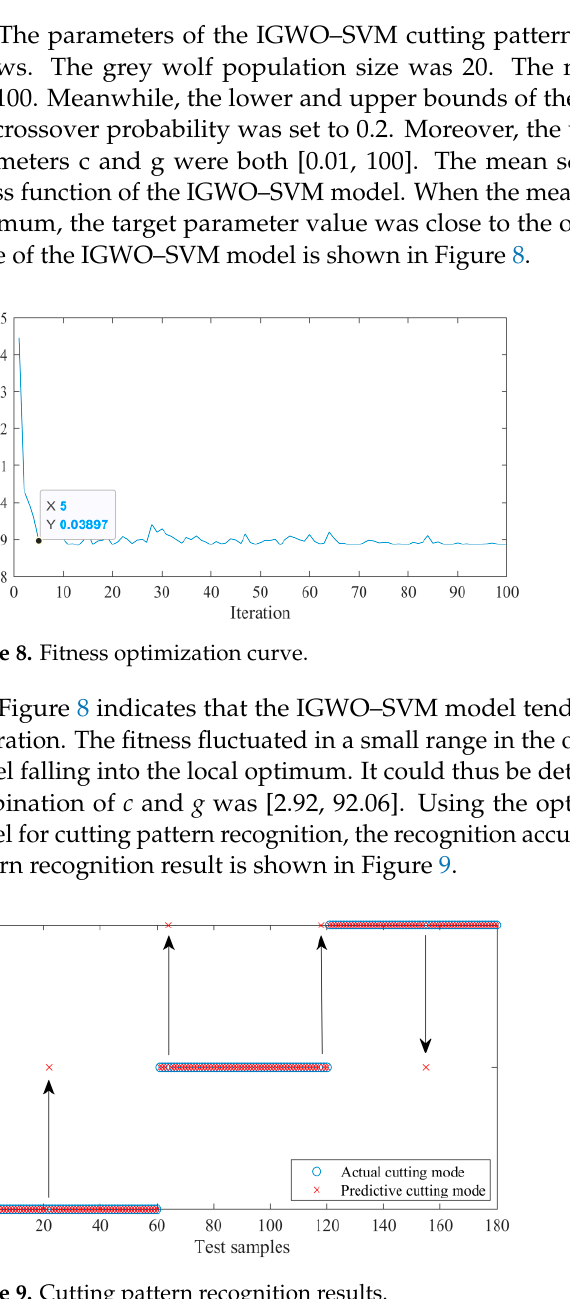
Table 3. Performance comparison of four cutting pattern recognition models.